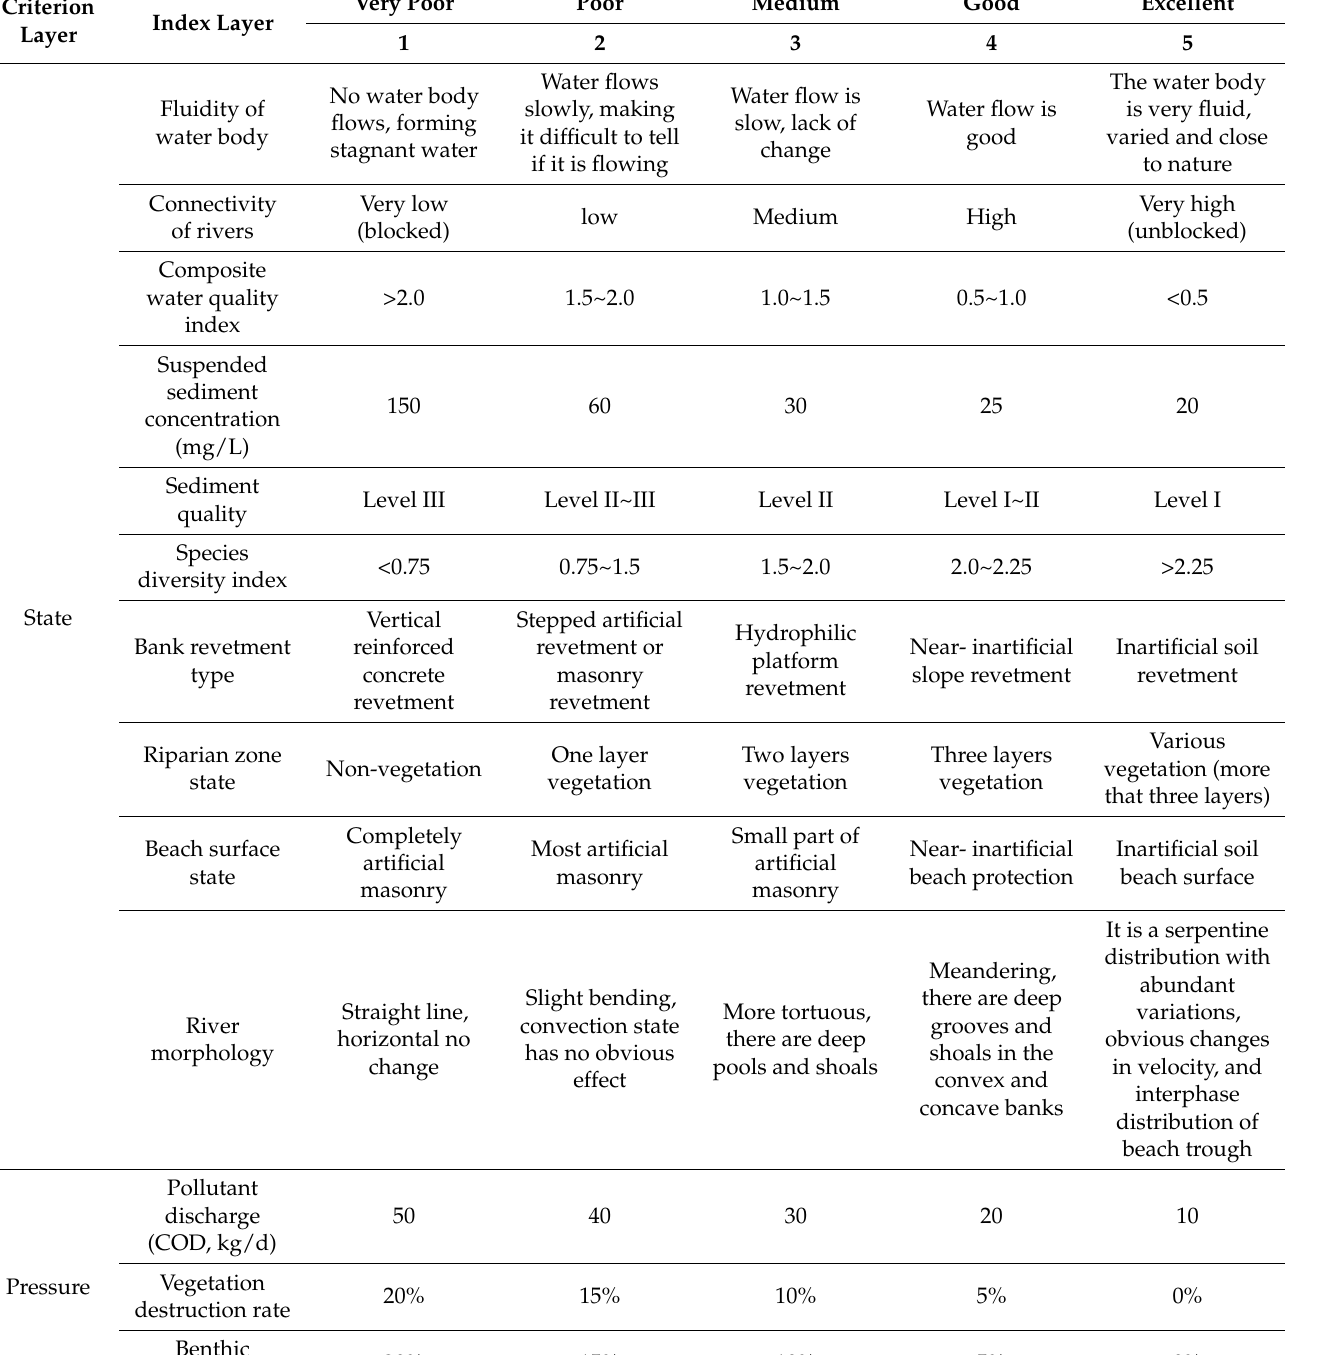
Table 2. Evaluation criteria for ecological effect of waterway engineering in the lower reaches of the Yangtze